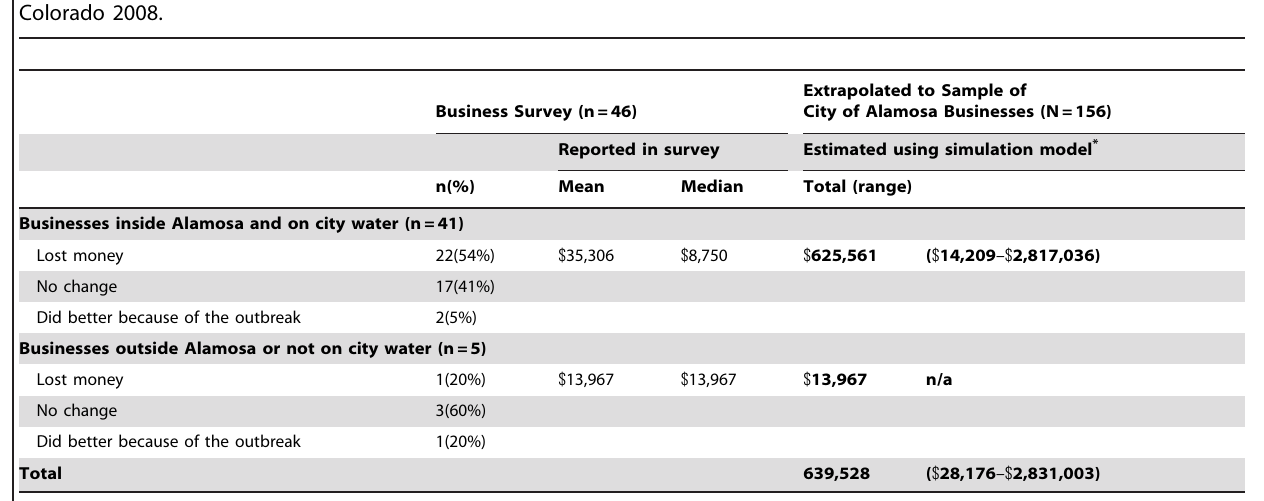
Switched from tap to bottled water (n=249) *